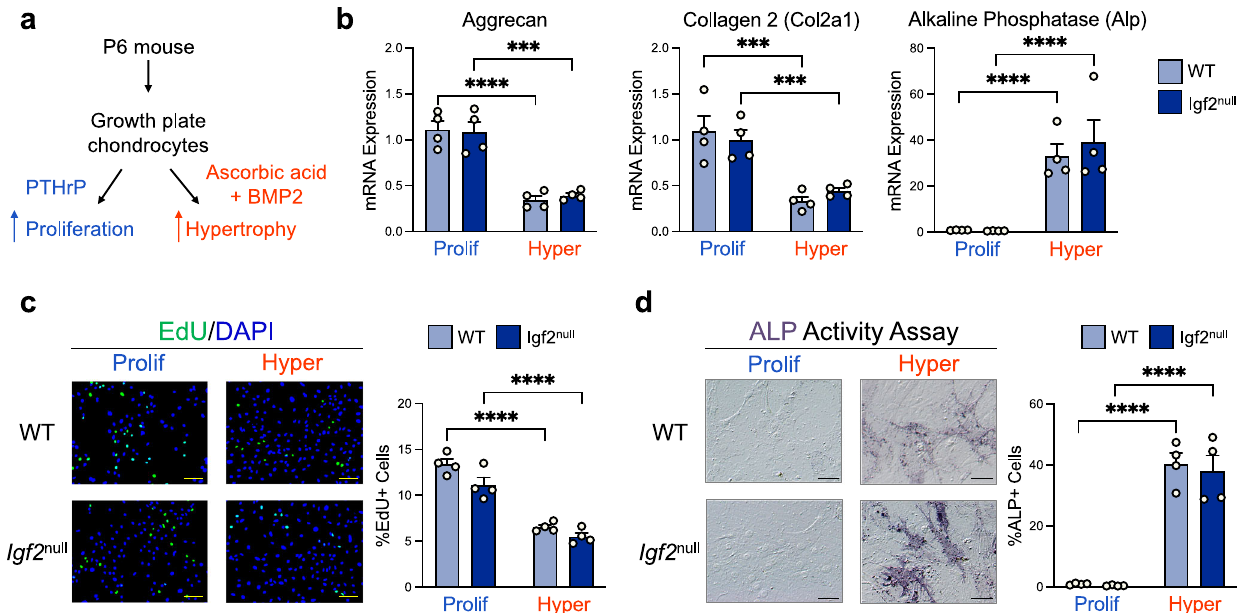
Fig. 1 Murine epiphyseal chondrocytes can be enriched to proliferating and hypertrophic phenotypes. a Schematic of the experimental design used to enrich populations of chondrocytes to proliferating ( “ Prolif ” ) and hypertrophic ( “ Hyper ” ) phenotypes. b Gene expression of aggrecan, collagen 2 (proliferation marker genes), and alkaline phosphatase (hypertrophic marker gene) was measured by RT-qPCR in proliferating and hypertrophic epiphyseal chondrocytes from WT and Igf2 null mice. c Assessment of proliferating chondrocytes by EdU staining. d Assessment of chondrocyte hypertrophy by alkaline phosphatase activity staining. Scale bar: 100 µ m. Data are presented as individual measurements with mean + SEM, representative of n = 5 experiments with 2 – 4 wells per group. Statistical signi fi cance was calculated using two-way ANOVA with Tukey ’ s test for multiple comparisons ( b , c , d ). p -values indicated as * p < 0.05, ** p < 0.01, *** p < 0.001, **** p <